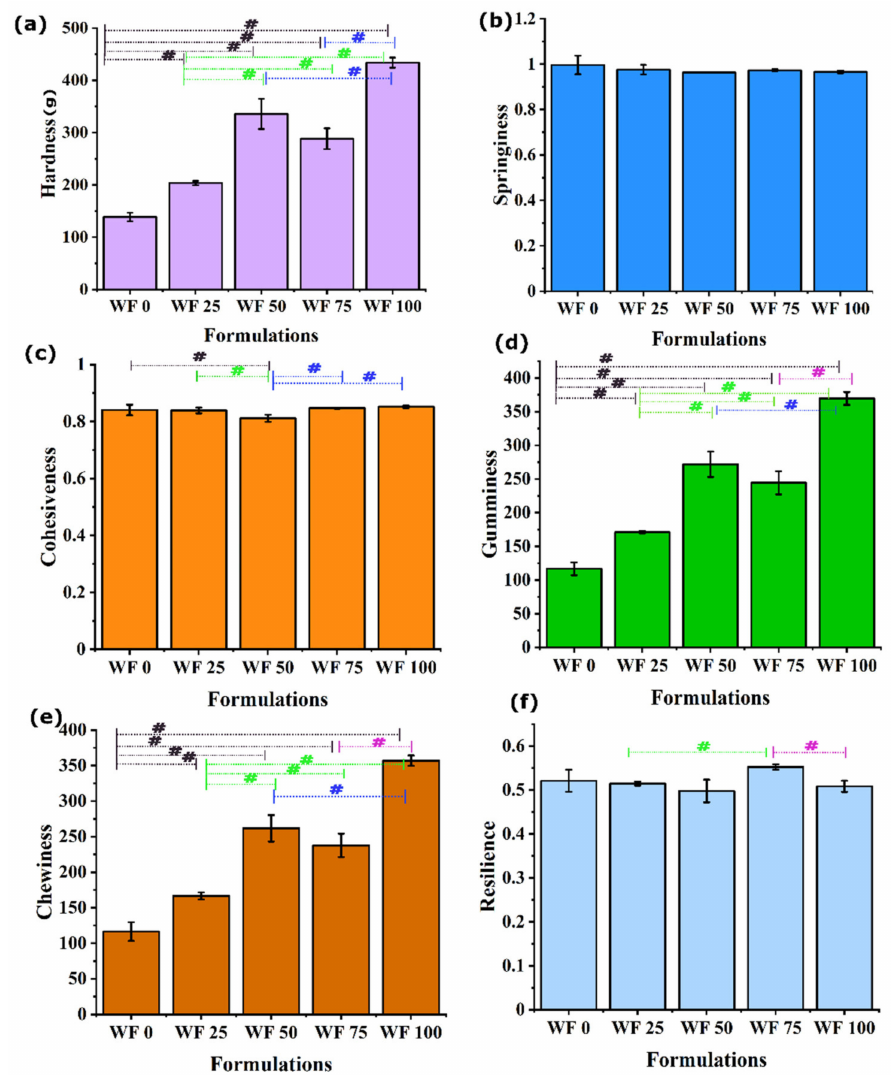
Figure 7. Graphs representing parameters obtained from TPA: ( a ) Hardness; ( b ) springiness; ( c ) cohesiveness; ( d ) gumminess; ( e ) chewiness; ( f ) resilience. Data are represented as mean ± SD of triplicates (# p <